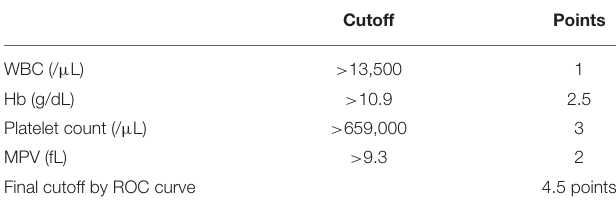
TABLE 4 | The cut-off and points for scoring